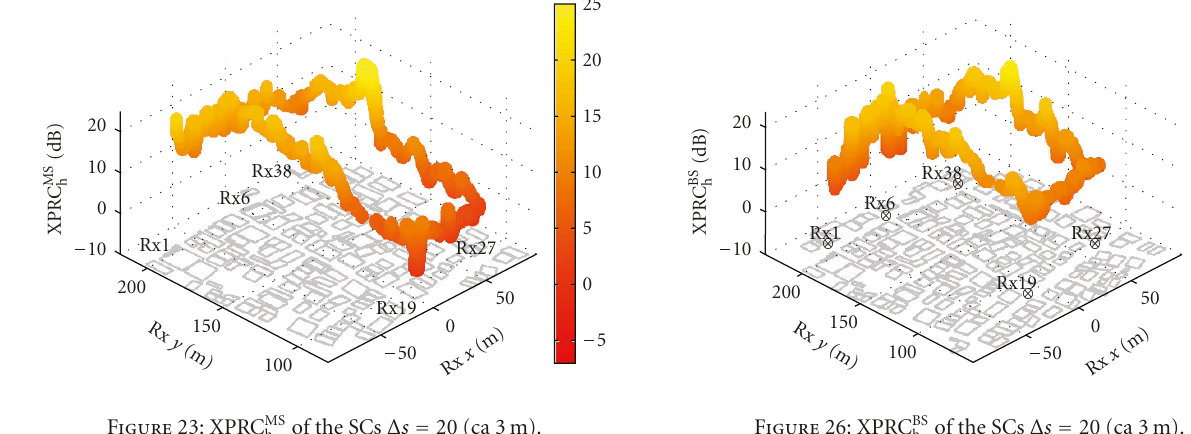
of the SCs Δ s = 20 (ca 3m). h